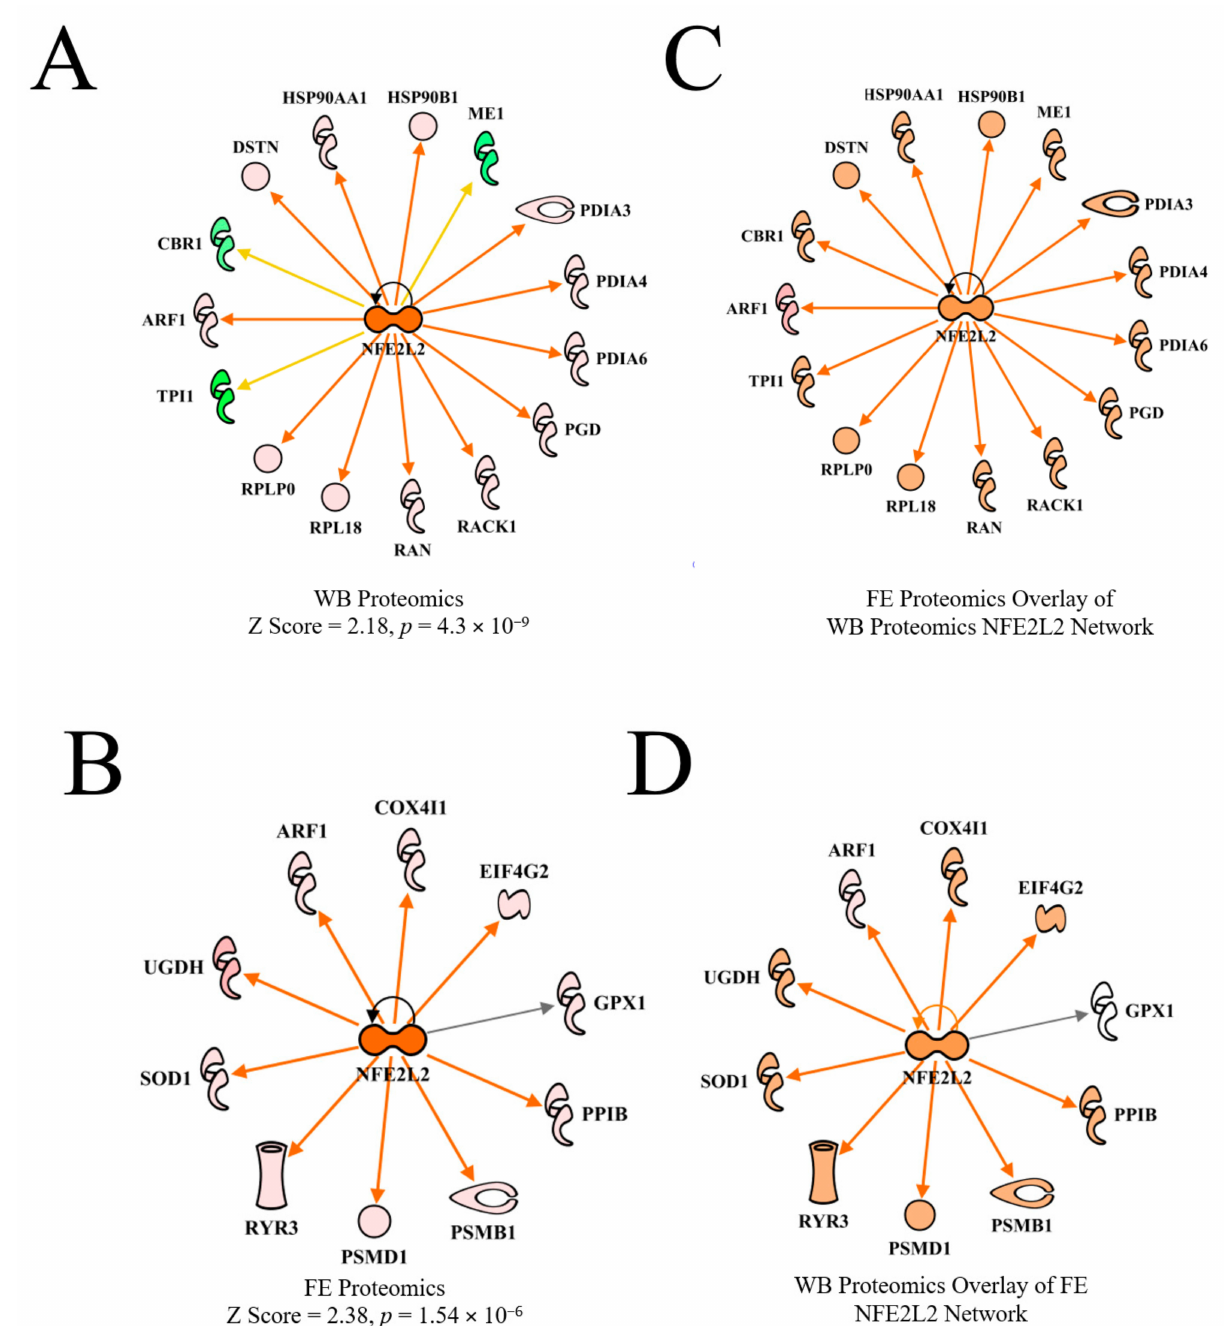
Figure 8. The upstream regulator network for NFE2L2 (nuclear factor (erythroid-derived 2)-like 2) for wooden breast (WB) myopathy (activation Z score = 2.18, 4.3 × 10 − 9 ) compared to normal muscle ( A ) and for the high vs. low PedM broiler feed efficiency (FE) proteomic data (activation Z score = 2.38, p = 1.54 × 10 − 6 ) ( B ). Overlay of the FE data on the WB myopathy data ( C ) and vice versa ( D ) both resulted in predicted activations of NFE2L2. Protein abbreviations in B and D in the FE data set are as follows: ARF1 (ADP-ribosylation factor 1), COX4I1 (cytochrome oxidase subunit IV isoform 1), EIF4G2 (eukaryotic translation initiation factor 4 gamma 2), GPX1 (glutathione peroxidase 1), PPIB (peptidylprolyl isomerase B (cyclophilin B), PSMB1 (proteosome 26S subunit beta type, 1) PSMD1 (proteosome 26S subunit non-ATPase, 1), RYR3 (ryanodine receptor 3), SOD1 (superoxide dismutase 1), UGDH (UDP-glucose 6-dehydrogenase). Under normal (non-oxidant stress) conditions, the NFE2L2 protein remains bound to Cullin3 (CUL3) and Kelch like-ECH protein 1 (KEAP1), and is then rapidly directed